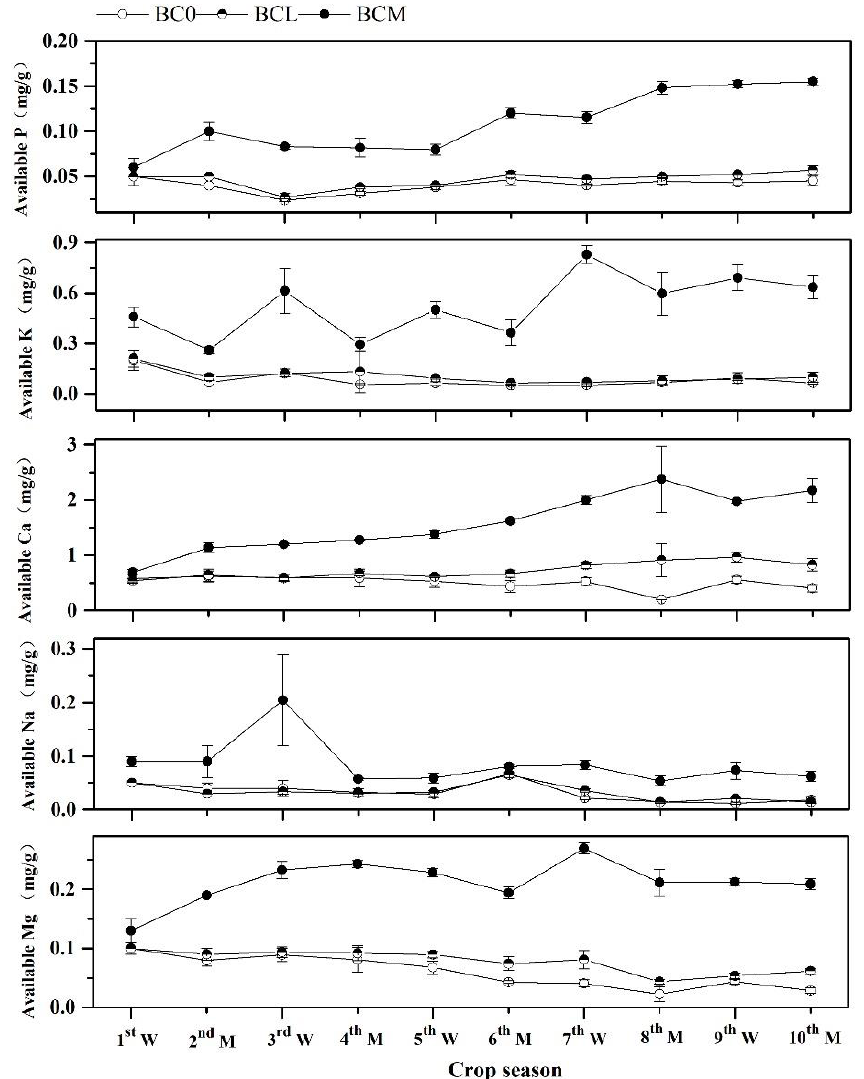
Figure 4. The change of soil available P, K, Ca, Na and Mg content in red soil affected by successive applications of straw biochar during 10 consecutive wheat/millet growing seasons from 2010–2015. Error bars are standard deviations.